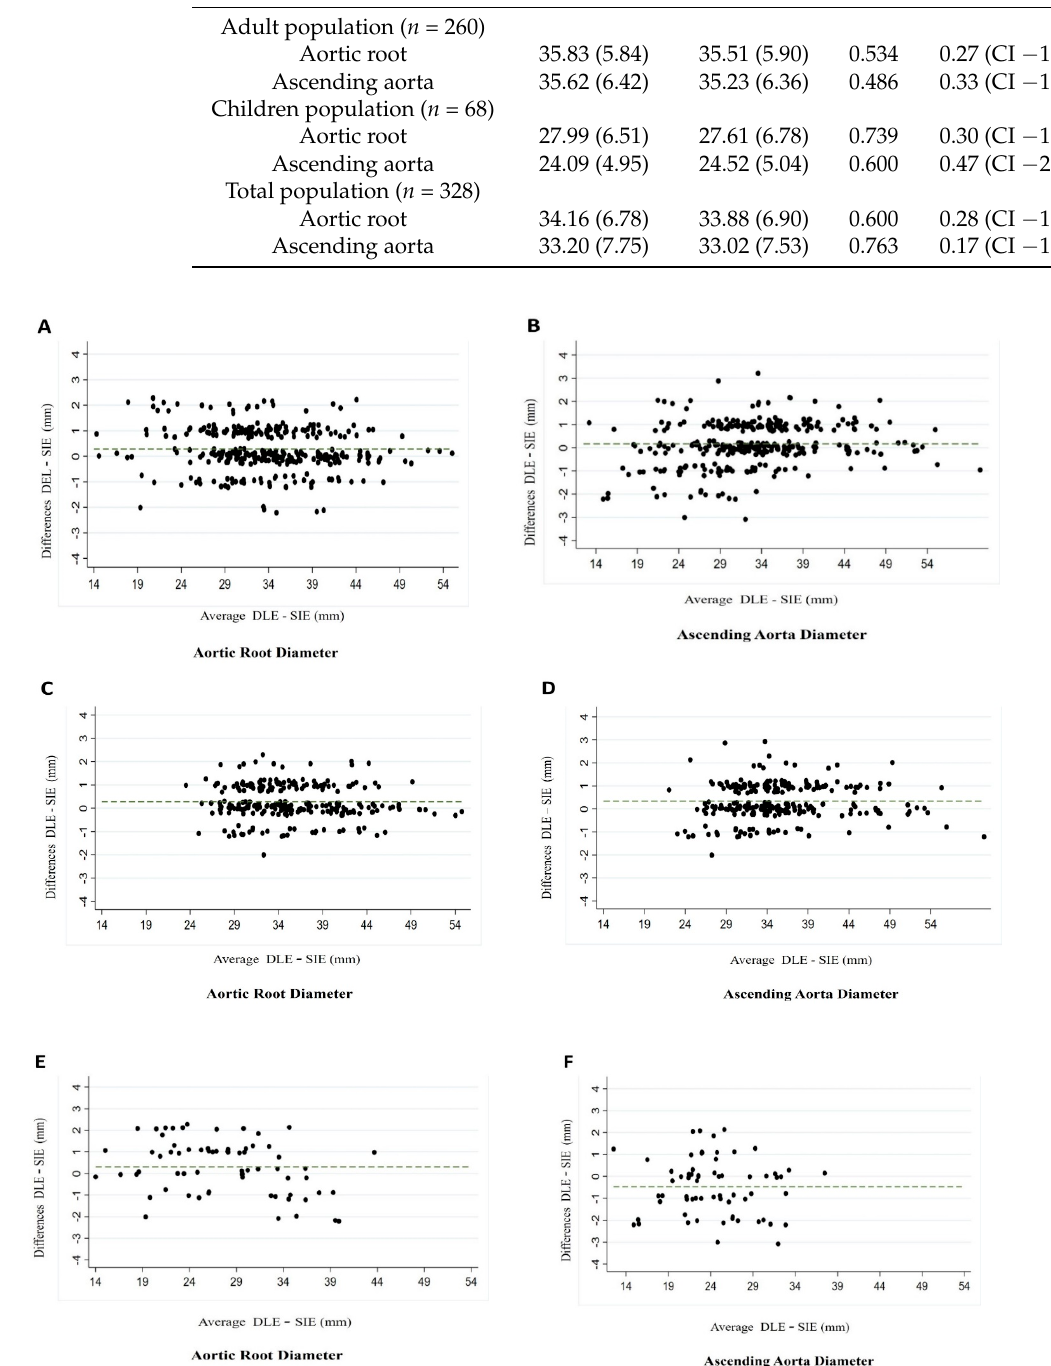
Figure 2. Bland–Altman plots showing the mean of the differences at the level of the aortic root ( A ) and ascending aorta ( B ) in the total population. Bland–Altman plots showing the mean of the differences at the level of the aortic root ( C ) and ascending aorta ( D ) in the adult population. Bland–Altman plots showing the mean of the differences at the level of the aortic root ( E ) and ascending aorta ( F ) in the children population.